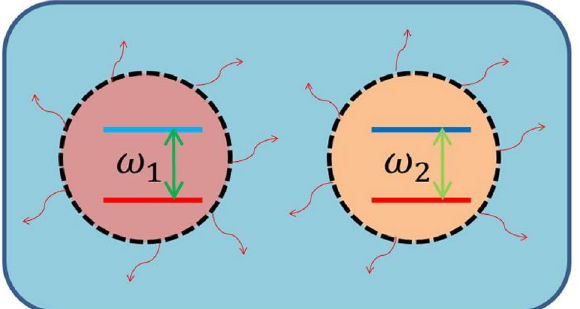
Figure 1. Schematic of two-qubit system undergoing dissipative dynamics via the interaction with a common thermal